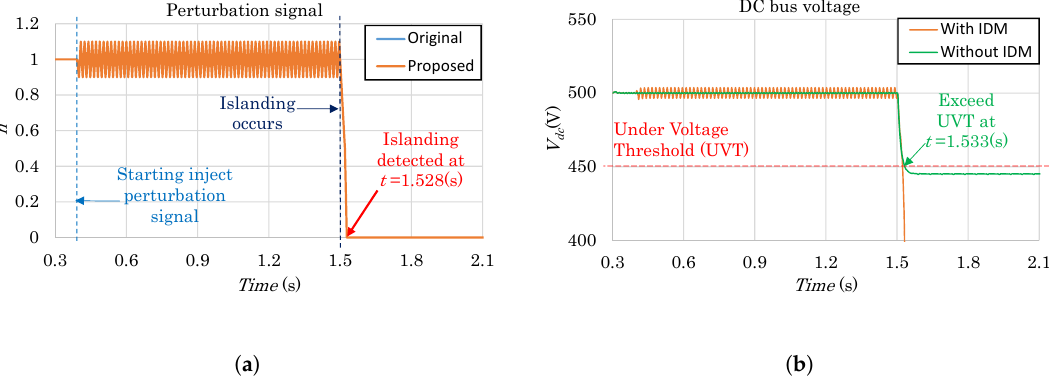
Figure 11. Result in case of single PV operation, 50 kW PV, another islanding condition: ( a ) Perturbation signal and ( b ) DC bus voltage (with and without